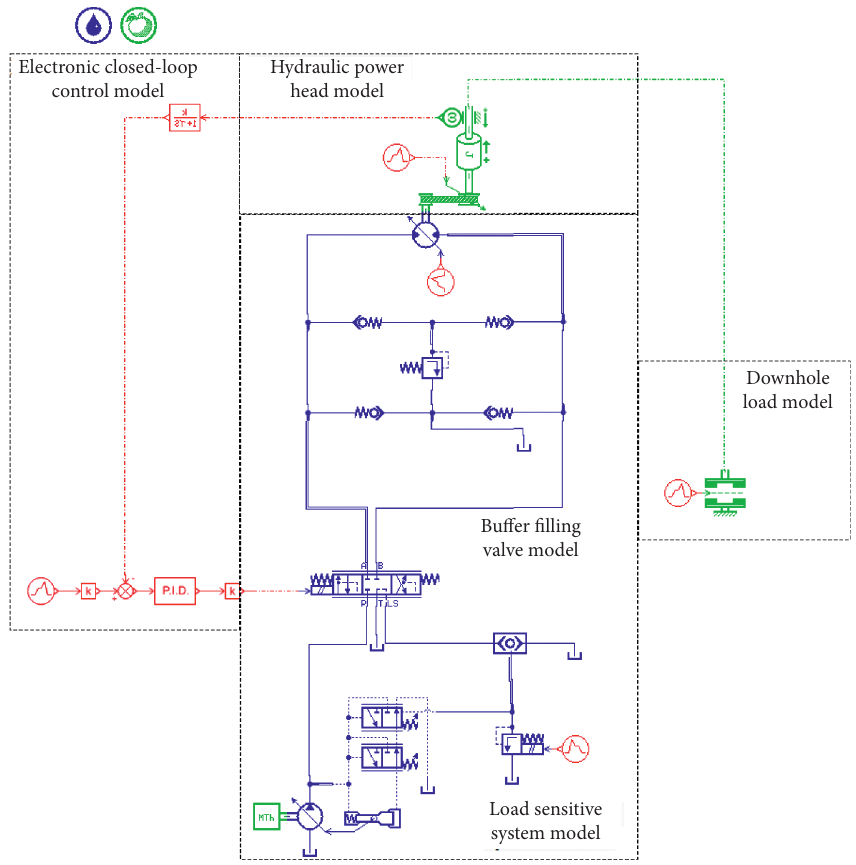
Figure 2: Simulation model of power head of the geological drilling rig.